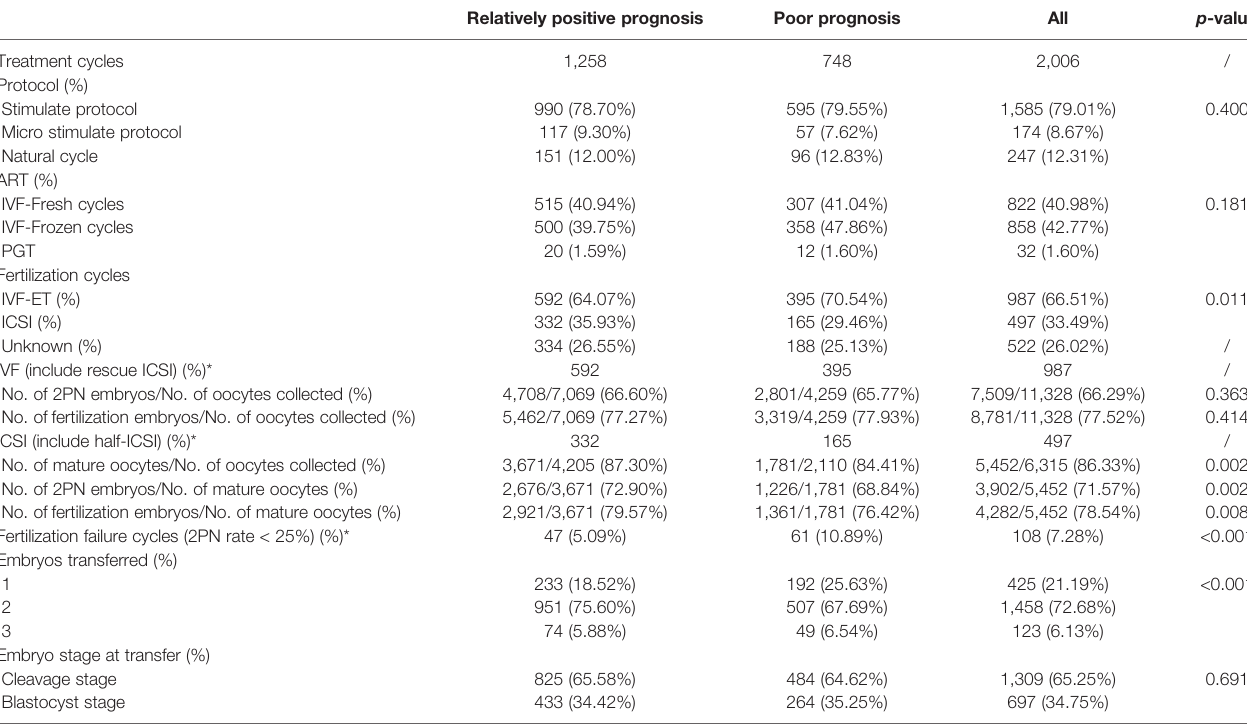
TABLE 3 | Characteristics of IVF.